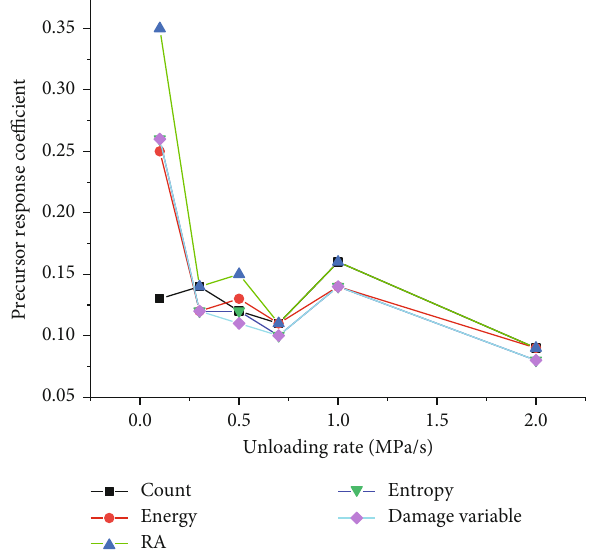
Figure 8: The relationship curve between precursor response coe ffi cient and unloading